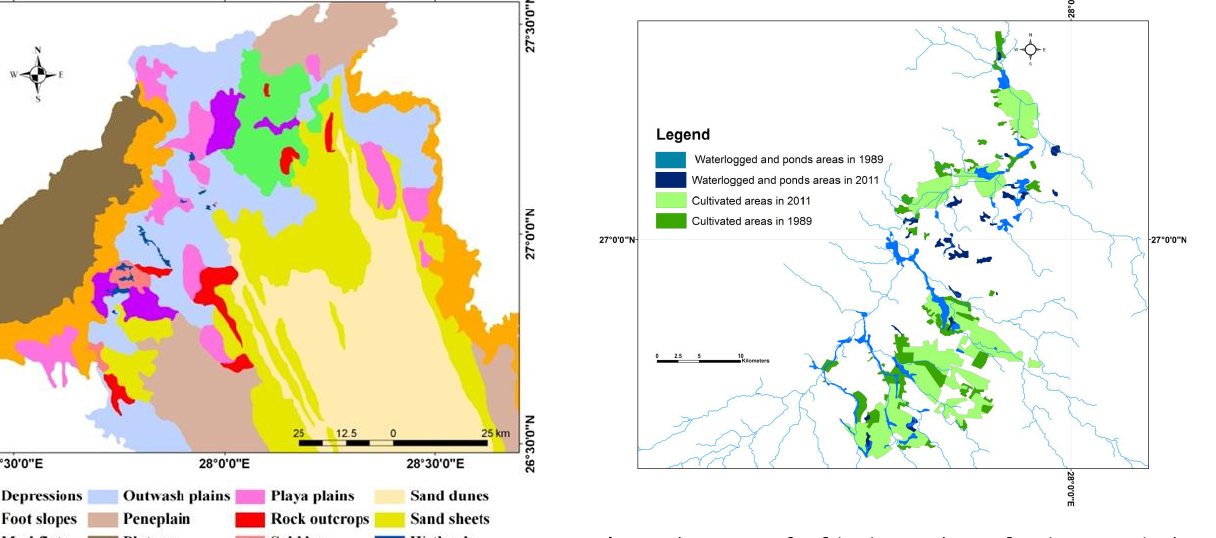
615 Fig 6: Map shows the main landforms delineated from the satellite images and DEM for 616 the Farafra Oasis. These units were checked for accuracy in the field. 617 Fig. 6. Map shows the main landforms delineated from the satellite 618 images and DEM for the Farafra Oasis. These units were checked 619 for accuracy in the field.